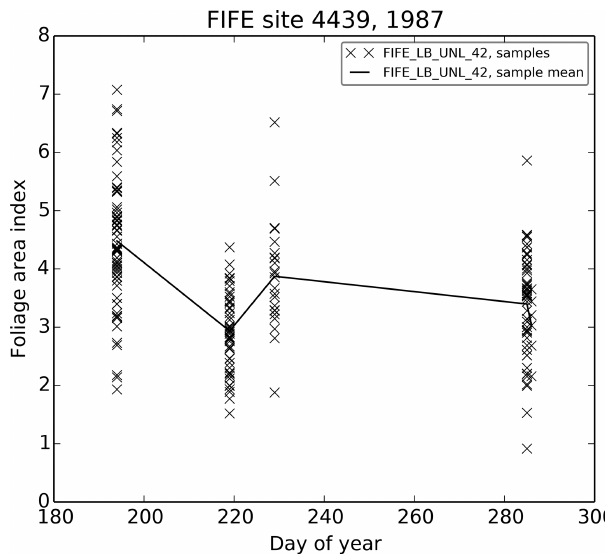
Figure A2. Foliage area index observations from FIFE_LB_UNL_42 for site 4439 in 1987.